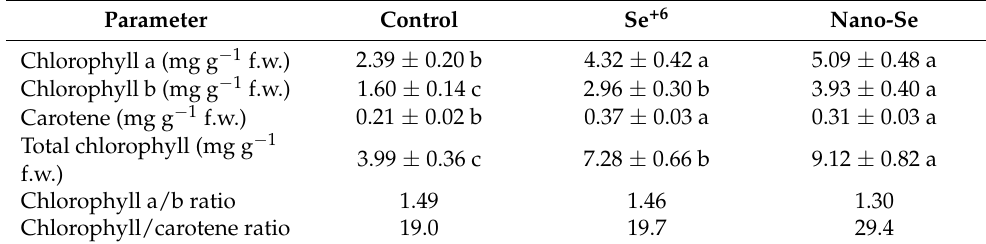
Table 2. Photosynthetic pigments of A. annua leaves.